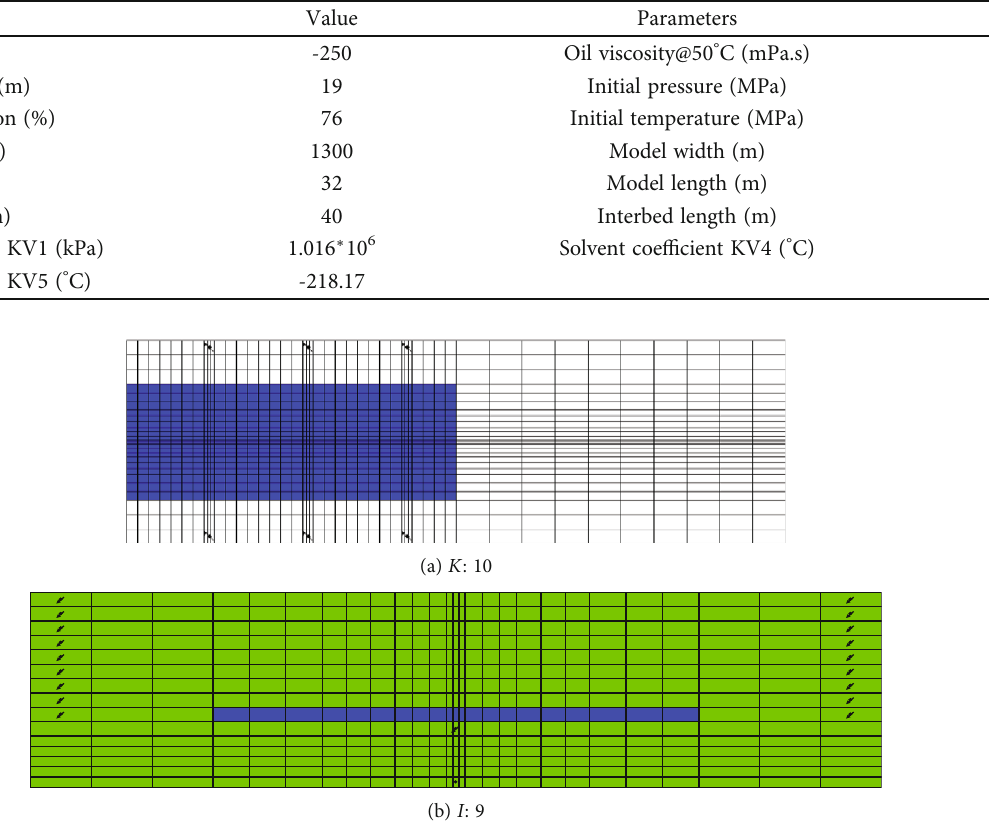
Figure 13: Schematic of well con fi guration in the